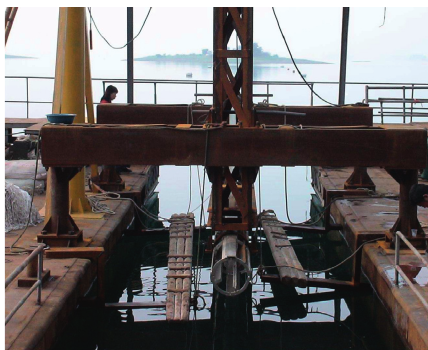
Figure 13: Lakebed autonomous flight experimental model.